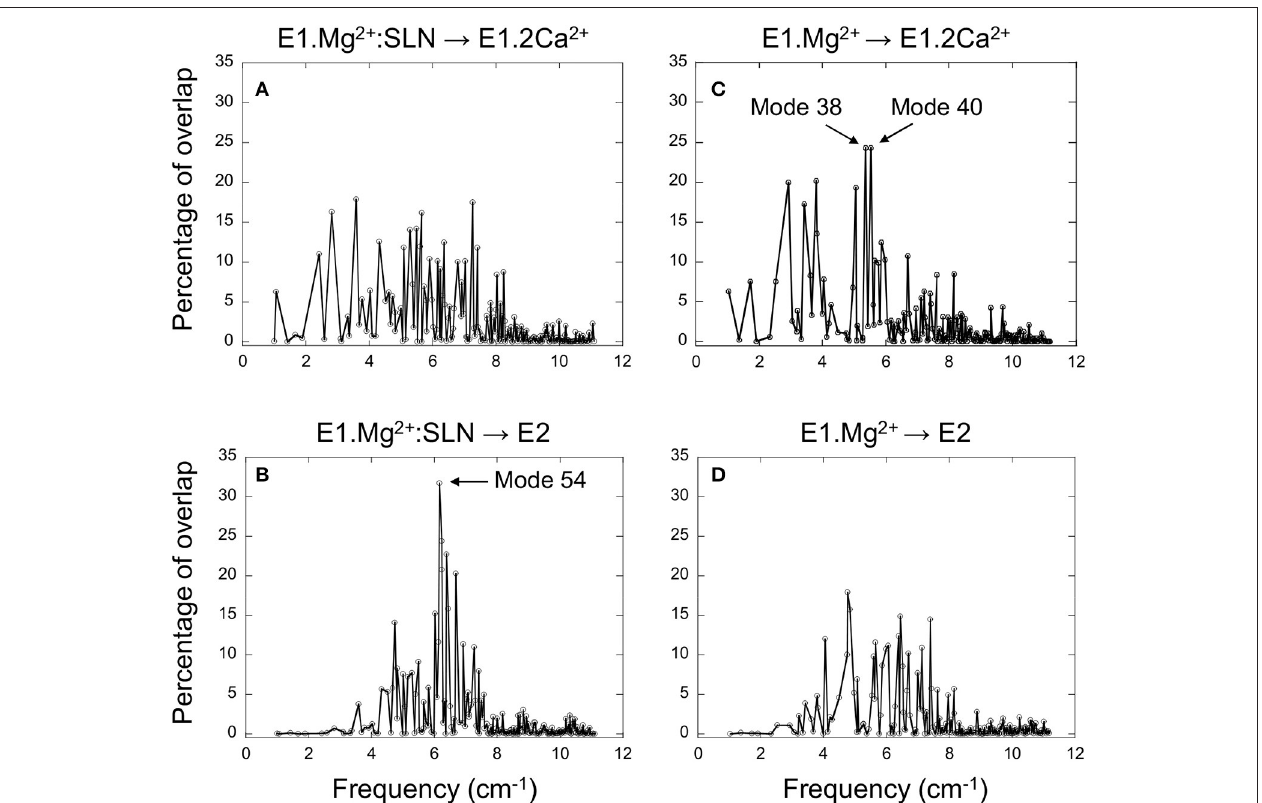
FIGURE 2 | Projection of the normal modes on the difference coordinate vectors. Percentage of overlaps between the 200 NMs of E1.Mg 2 + :SLN and the difference vectors E1.Mg 2 + :SLN → E1.2Ca 2 + (A) and E1.Mg 2 + :SLN → E2 (B) . Percentage of overlaps between the 200 NMs of E1.Mg 2 + and the difference vectors E1.Mg 2 + → E1.2Ca 2 + (C) and E1.Mg 2 + → E2 (D) . E1.Mg 2 + :SLN and E1.Mg 2 + are energy-minimized structures and E1.2Ca 2 + and E2 are crystal structures (PDB ID: 1VFP and 3W5C, respectively). Only C α atoms are considered for these